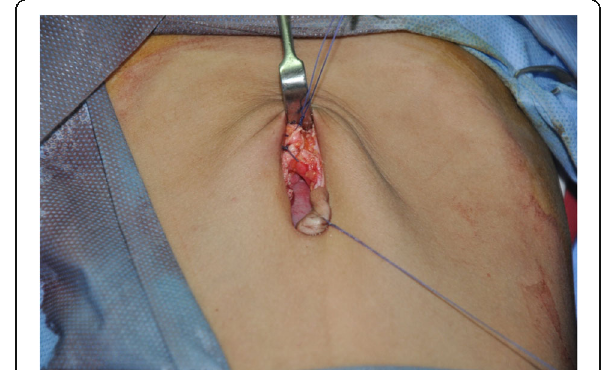
Fig. 4 Marking the site of incision for pyloroplasty by